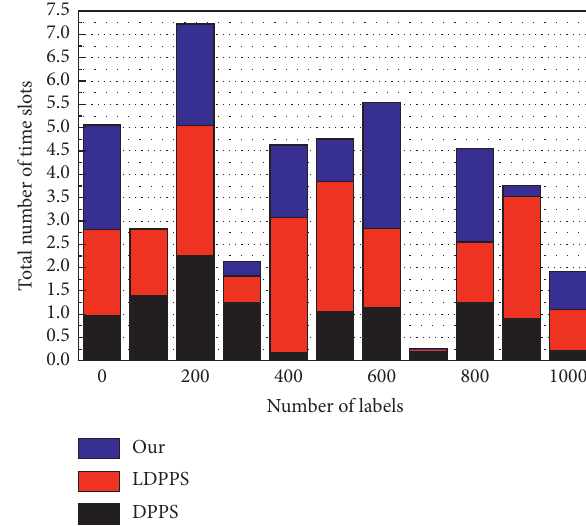
Figure 7: Throughput rate comparison.